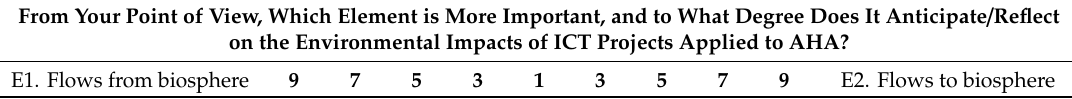
Table 2. Experts’